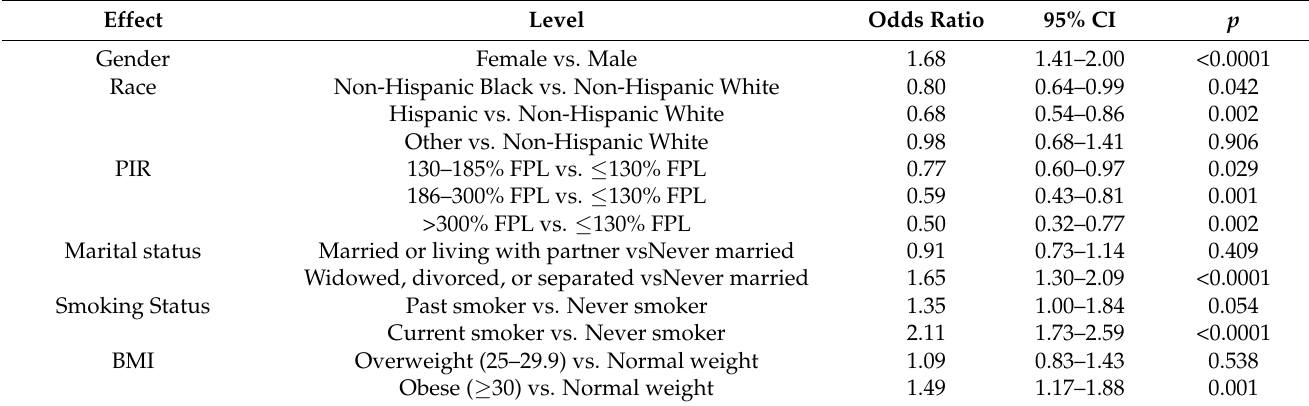
Table 3. Model fitting for odds of depression among food insecure